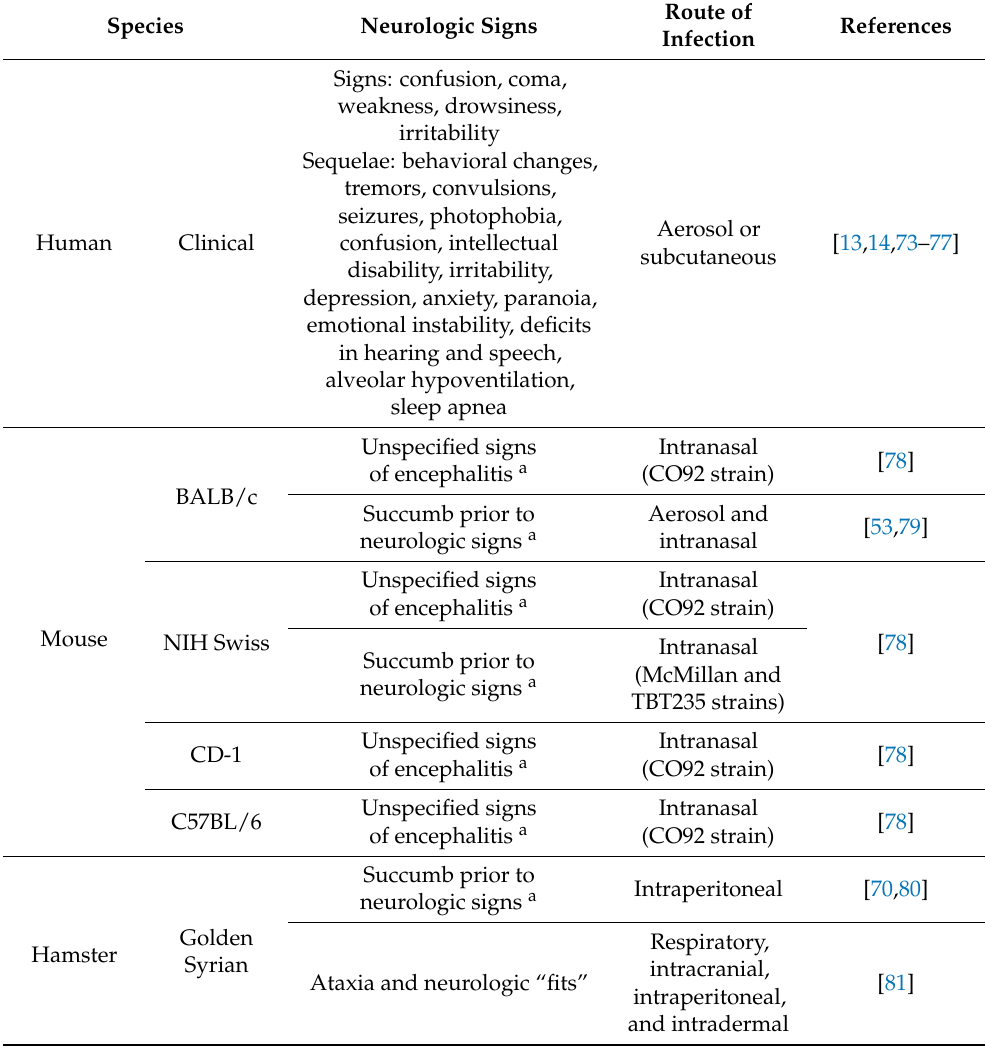
Table 3. Clinical and animal modeling of neurologic disease with western equine encephalitis virus (WEEV) infection. a strain